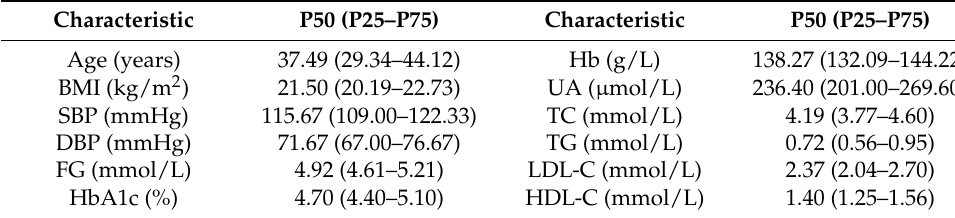
Figure 1. Exclusion schematic to establish reference range for vitamin K evaluating indicators in Chinese women of childbearing age. CACDNS, Chinese Adult Chronic Disease and Nutrition Surveillance; Hb, hemoglobin; BMI, body mass index; UA, uric acid. * Healthy volunteers were obtained by sequential exclusion based on the above criteria. Table 2. Basic characteristics of the study population.